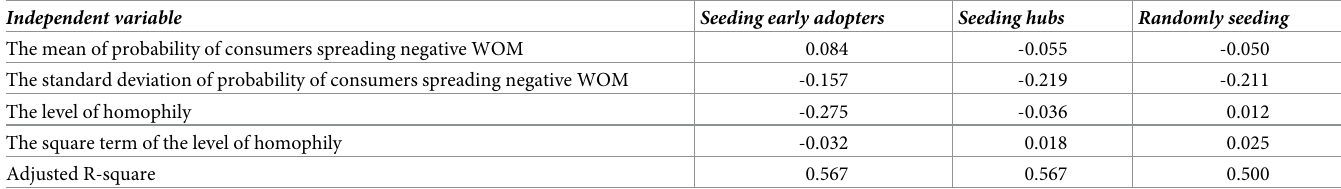
Table 3. Standardized coefficients of the independent variables for three seeding